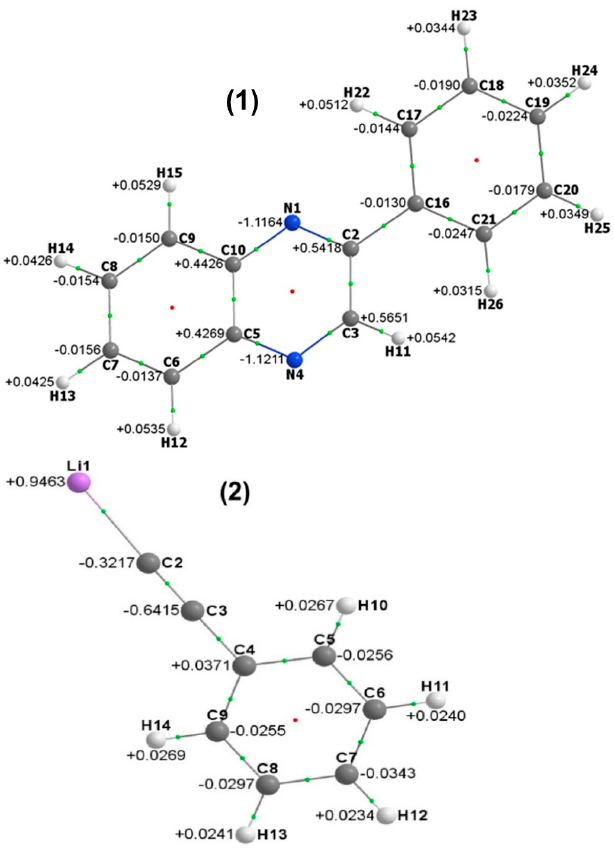
Figure 1. Molecular graph of 2-phenylquinxaline ( 1 ) and lithium phenylacetylide ( 2 ) showing QTAIM-defined net atomic charges in e.